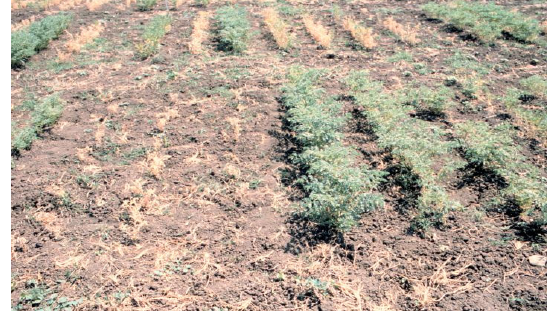
Figure 2. Chickpeas affected by Fusarium wilt in Beja ‐ Tunisia.